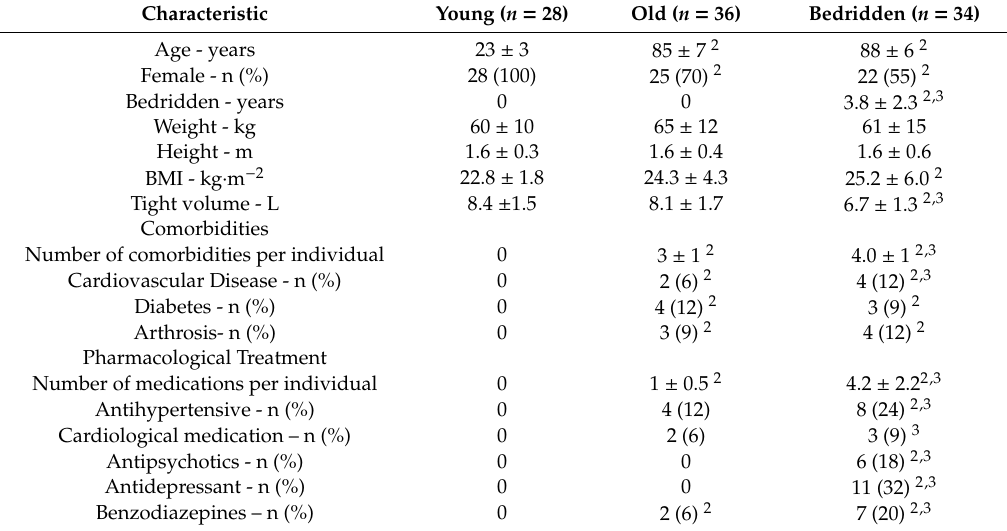
Table 1. Subjects characteristics 1